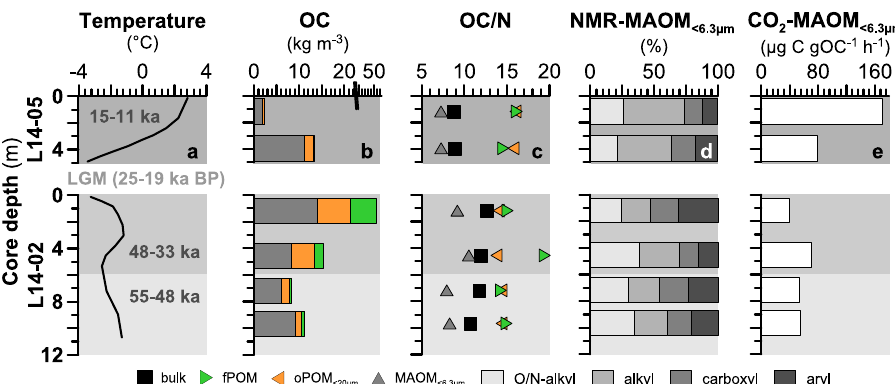
of mass fractions in kgm -3 ; c OC/N ratios of all fractions in colored symbols (green for free particulate OM – fPOM; orange for occluded particulate OM – oPOM; dark gray for MAOM <6.3 µ m ) and the bulk OC as black symbols; the composition of MAOM <6.3 µ m based on 13 C Nuclear magnetic resonance (NMR) is shown in gray shades in panel d ; while panel e shows the microbial mineralization fl ux of